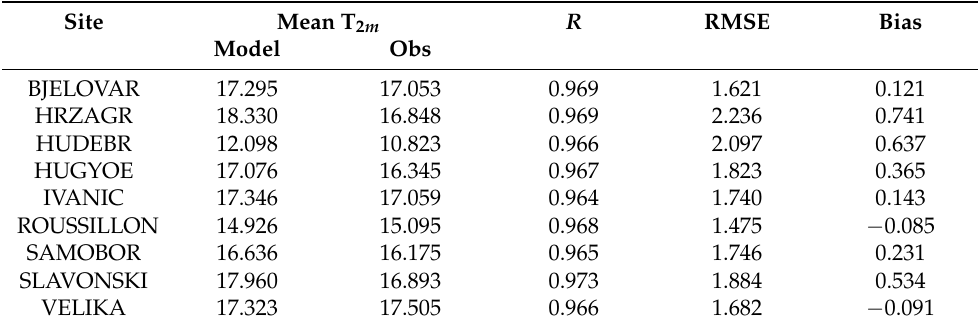
Table 4. Comparison between the 2 m temperature representing observations with the E-OBS database and the WRF model. Calculations are done for the stations of pollen counts retained for the study and for the whole year 2010 and using daily mean values. R is the Pearson correlation.